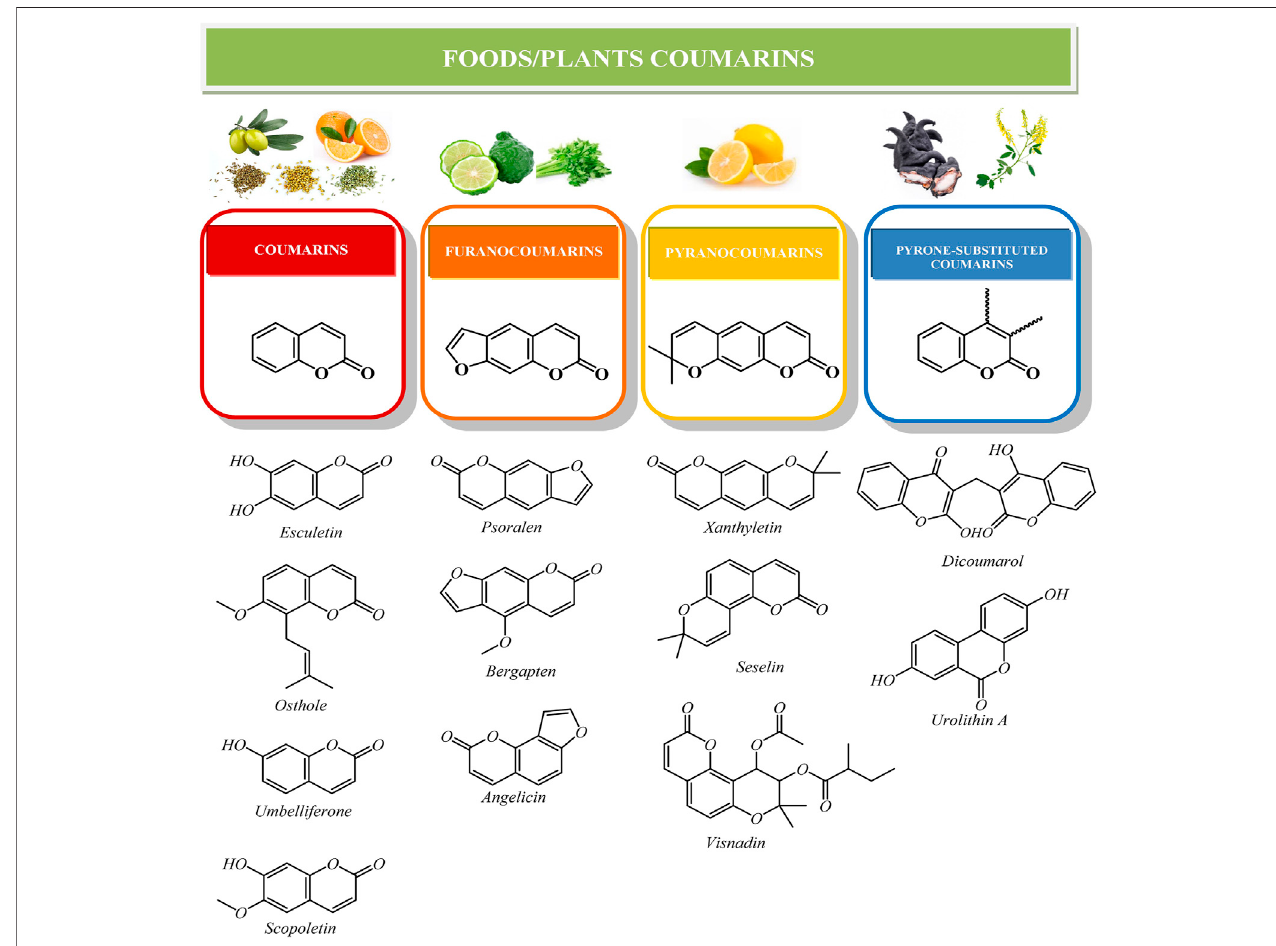
FIGURE 1 | Chemical structures of the main classes of natural